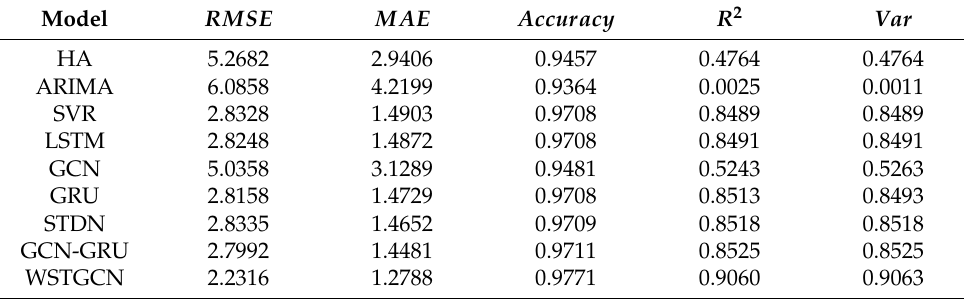
Table 3. Comparison of 15-min speed predictions.